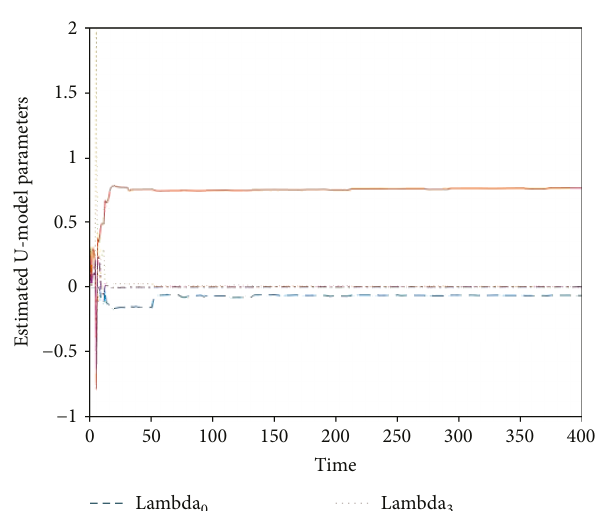
Figure 8: Plant output and control input.